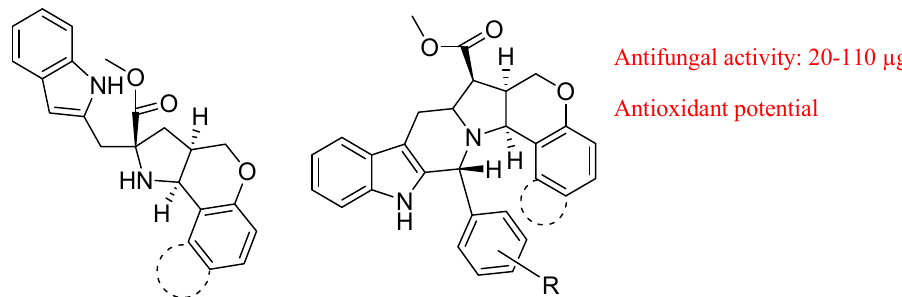
Figure 39. Chromeno[4,3-b]pyrroles and